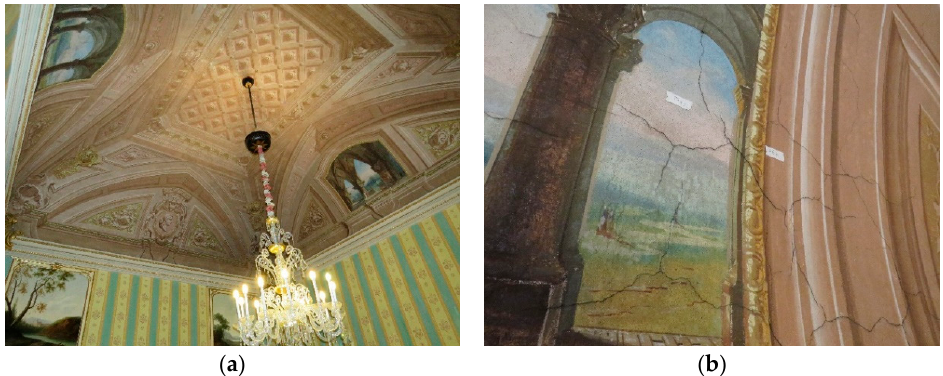
Figure 1. ( a ) Pelagi room at Birago Palace; ( b ) cracks branched in the decorated plaster of the masonry vault in the Pelagi room.